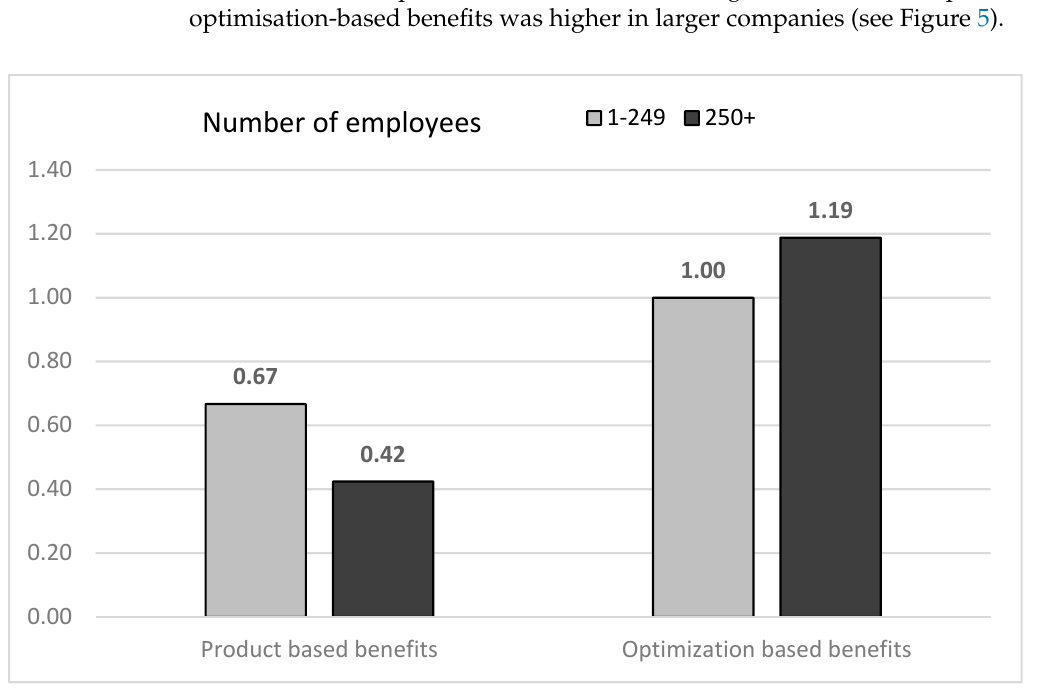
Figure 5. Mean values of product-based benefits and optimisation-based benefits in companies employing 1–249 workers and in companies employing at least 250 workers.